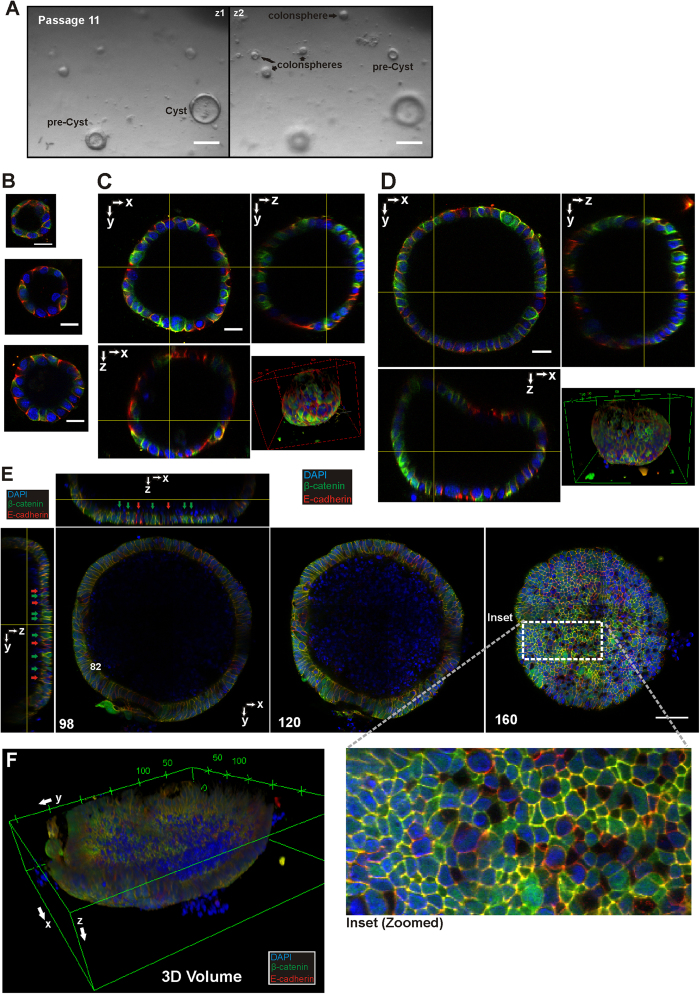
3D confocal imaging of colon adenoma cultures.(A) Bright field sectional images at different focal depths (z1 and z2) of colon adenoma cultures showing the different stages of development, namely from small colonospheres, increasing in size to pre-cyst (as the middle starts to collapse) and to a cystic structure. (B–F) Colonospheres and adenoma cysts are shown as RGB 2D images (blue:DAPI, green:β-cat, red:E-cad). (B) 2D overlay images of three small colonospheres increasing in size, showing the low frequency of distinct β-cat-high cells. (C–D) As the colonospheres increase in size, the number of β-cat-high cells increases in frequency. Orthoslice views and 3D reconstruction of two colonospheres (RBG overlays), showing the spherical shape of these structures and the gradual collapse of the top ceiling cell layer when dimensions increases (seen in D). (E) Orthoslice view and sectional 2D views (section 98, 120 and 160) of a large adenoma cyst showing how after collapsing, the structure flattens to form a “bowl” shape. Heterogeneous expressions of β-cat-high cells (green arrows) and E-cad-high cells (red arrows) are clearly identifiable along the surface of the cyst. (inset) A magnified region of the boxed (dotted) region of slice 160 shows clusters of β-cat-high cells and E-cad-high cells. (F) 3D reconstruction of the cyst showing the “bowl-like” shape of the structure. Scale bars: (A–D) 50 μm, (E) 100 μm.